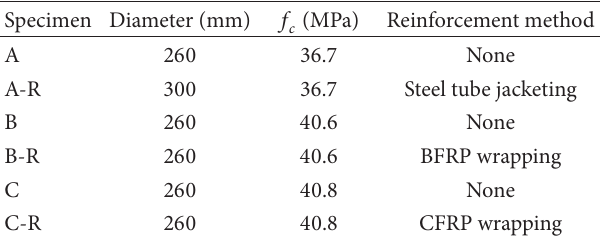
Table 1: Details of the specimens.